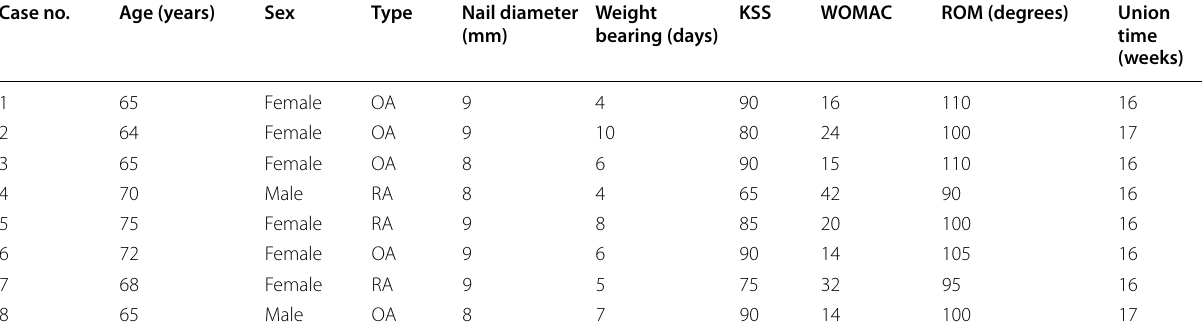
Table 1 The preoperative, intraoperative and postoperative characteristics Case no.